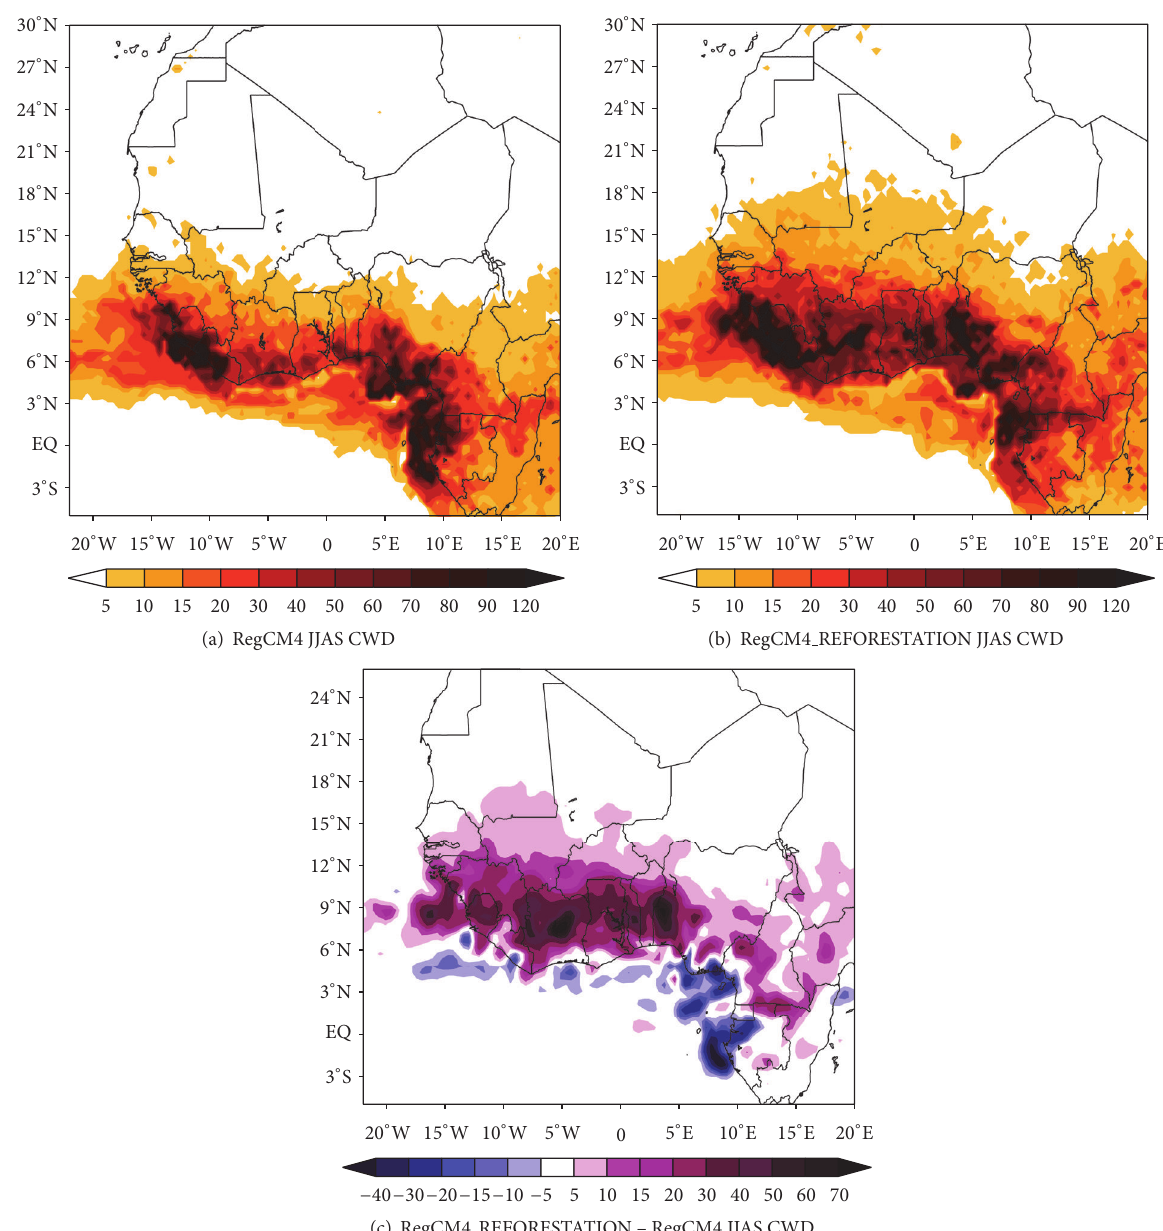
Figure 15: Maximum length of the consecutive wet days (CWD) for both runs and their difference averaged from 2003 to 2009.